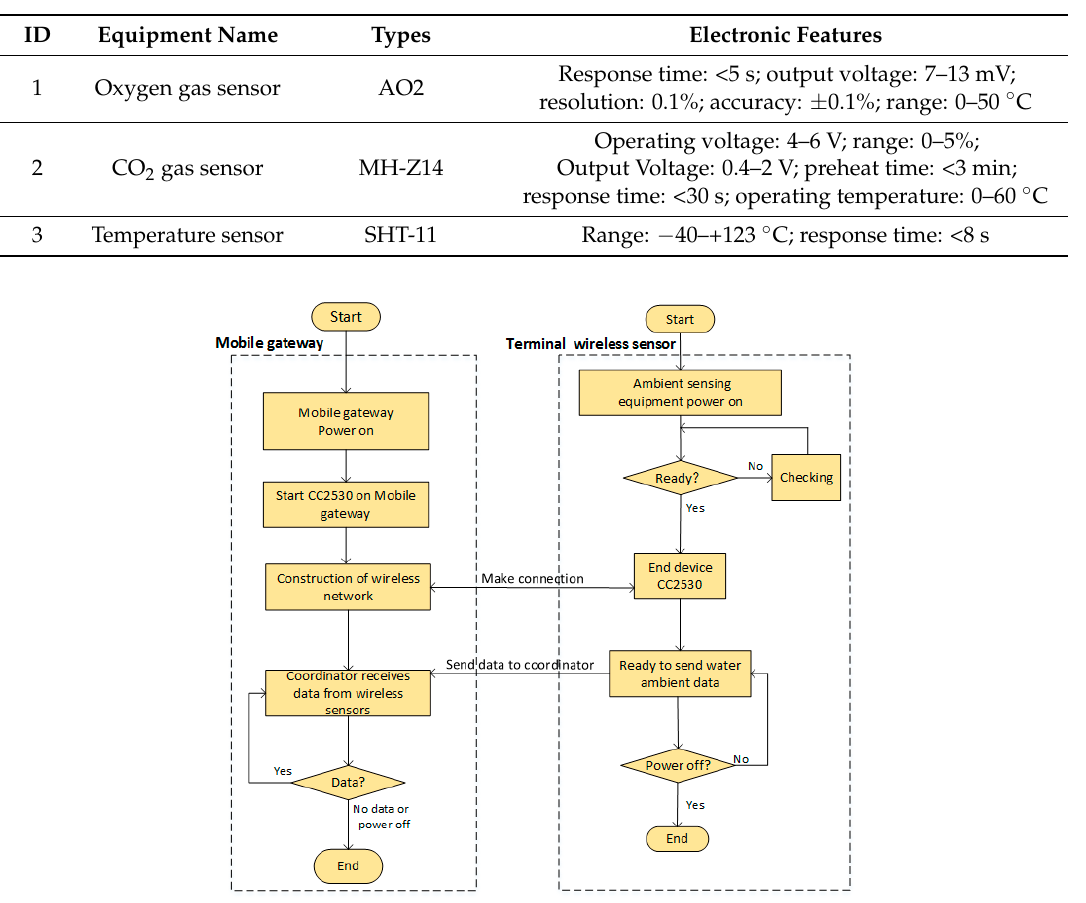
Table 1. The sensors for monitoring in flatfish waterless transportation.